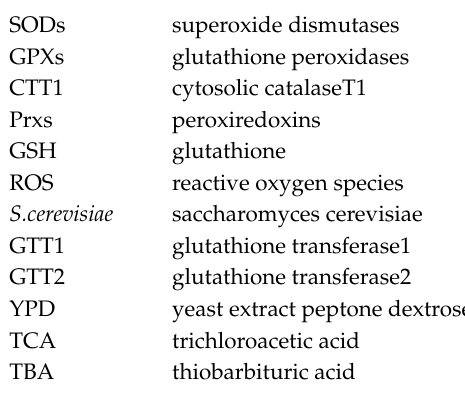
Figure S1: The 1H-NMR spectra (DMSO, 400 MHz) of hyperoside, FigureS2: The 13C-NMR spectra (DMSO, 100 MHz) of hyperoside, Figure S3: The HPLC spectra of hyperoside, Table S1: The analytical result of